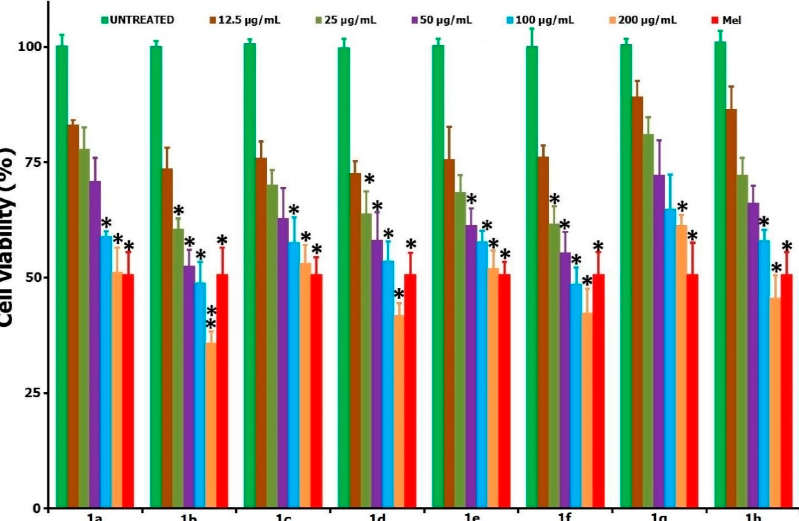
Figure 2. The percentage viability of HepG2 cancer cells when treated with the synthesized derivatives 1(a – h) in the concentration range of 12.5–200 μ g/mL and compared with that of positive (melphalan (Mel); 15 μ g/mL) and negative controls (no treatment) over a 24 h period. * and ** correspond to significant ( p < 0.05) and highly significant ( p < 0.01) values against the untreated control.